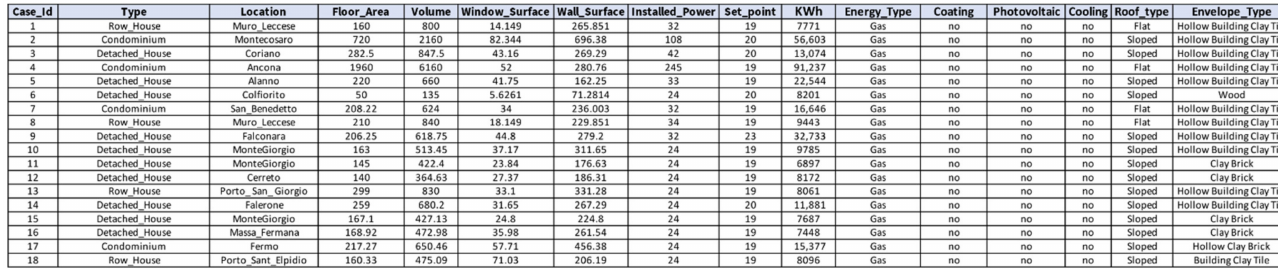
Figure 9. A fragment of the Case Base table.